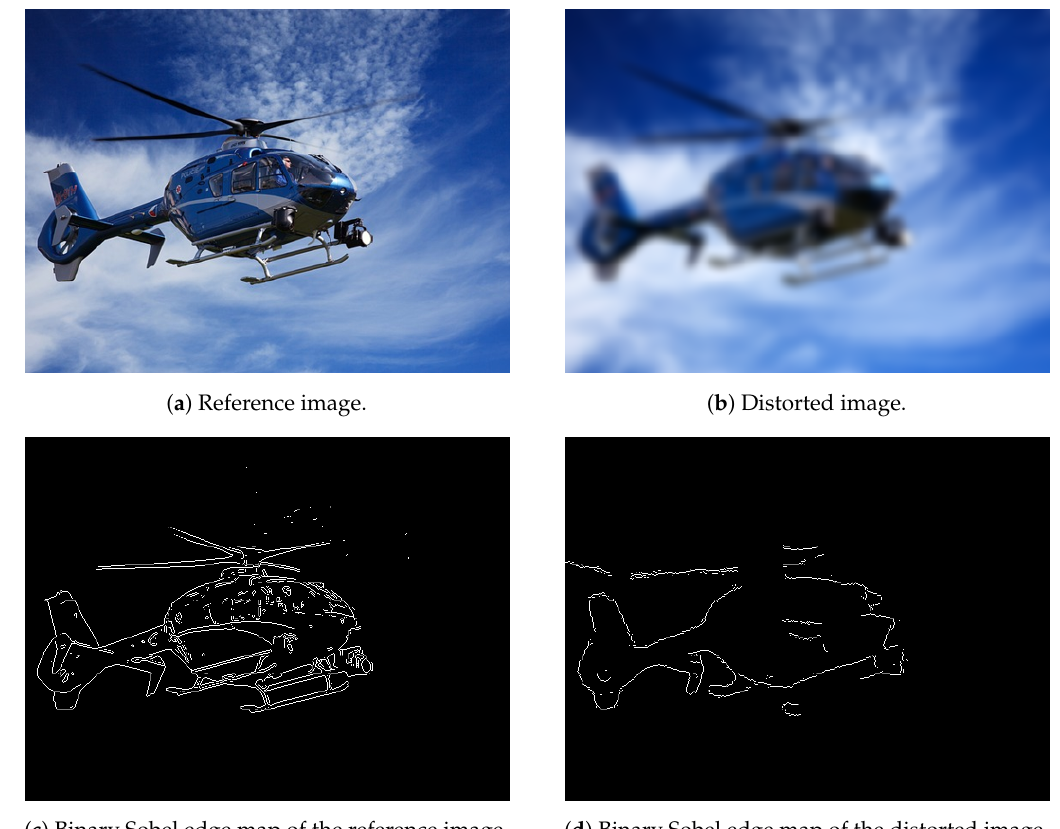
( c ) Binary Sobel edge map of the reference image. ( d ) Binary Sobel edge map of the distorted image. Figure 4. Structural distortions correlate well with the degradation. Central moments are applied as quality-aware features to quantify edge